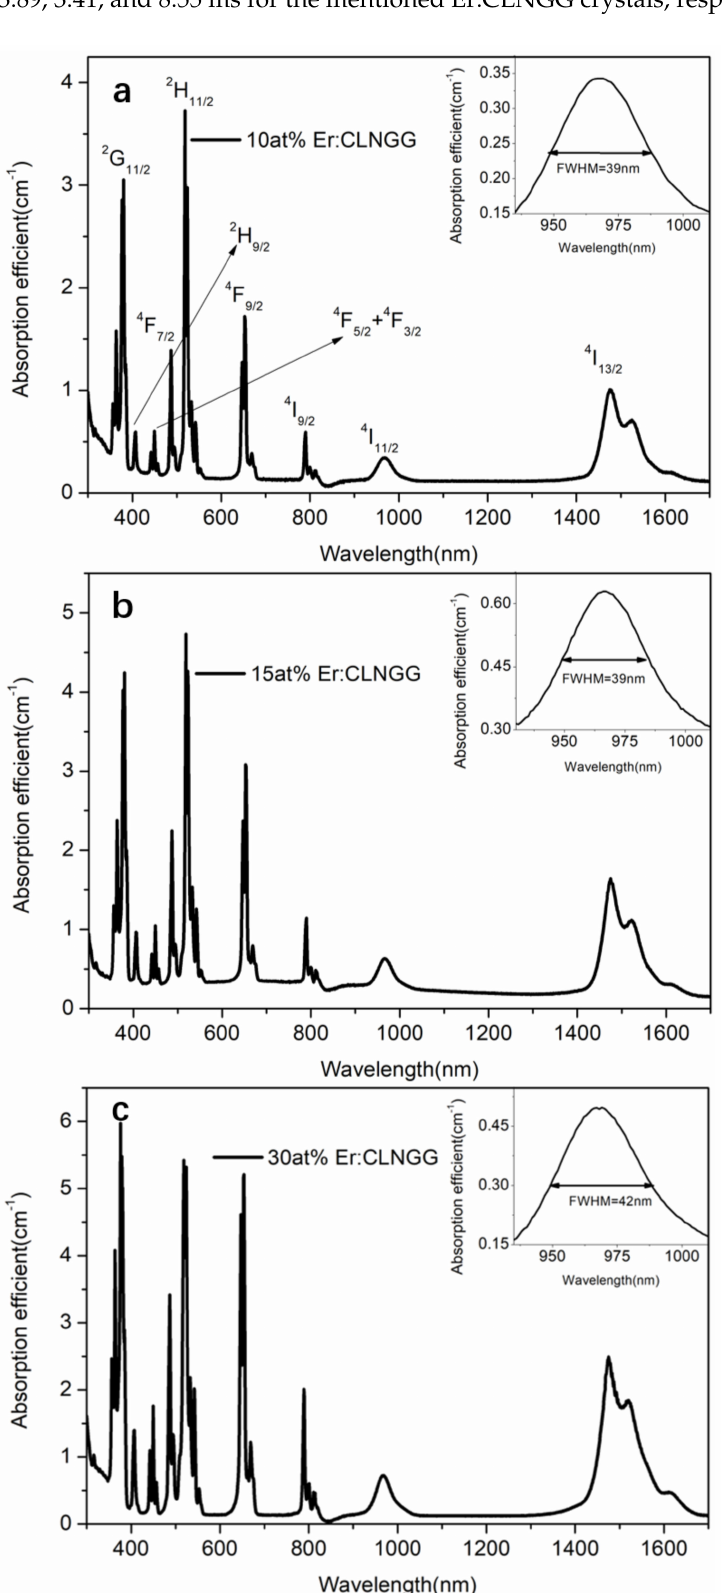
Figure 8. Absorption spectrum of ( a ) 10 at.% Er: CLNGG ( b ) 15 at.% Er: CLNGG ( c ) 30 at.% Er:CLNGG from 350 nm to 1650